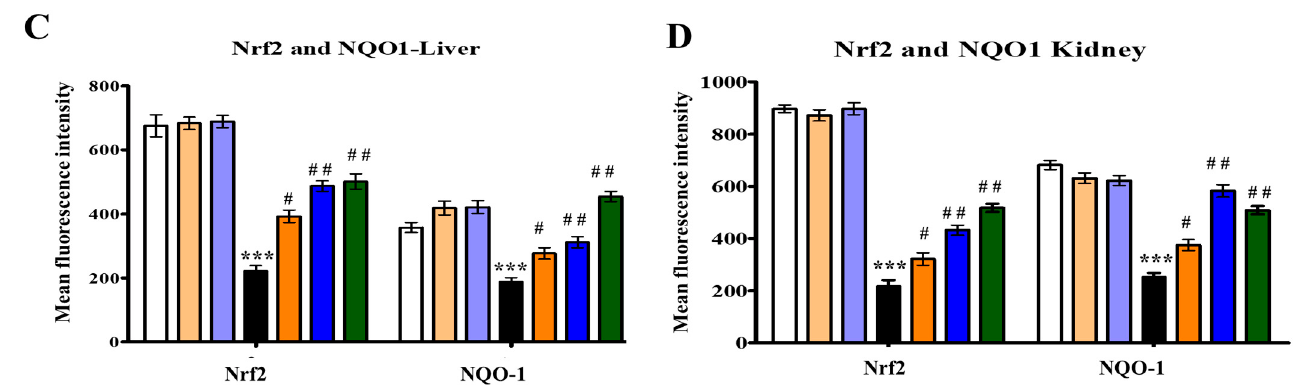
Figure 5. Representative confocal images of antioxidant markers Nrf2 (red) and NOQ1 (green) double immunofluorescence staining in the liver ( A ) and kidney ( B ) samples from BGH-treated rats. Quantitative analyses of immunofluorescence signals in the liver ( C ) and kidney tissues ( D ). The results were collected from six separate rats within every treatment group and were reported as a mean ± S.E.M. *** p < 0.001 vs. NC; # p < 0.05; ## p < 0.01 vs. DC. S Scale bar = 100 μ m.